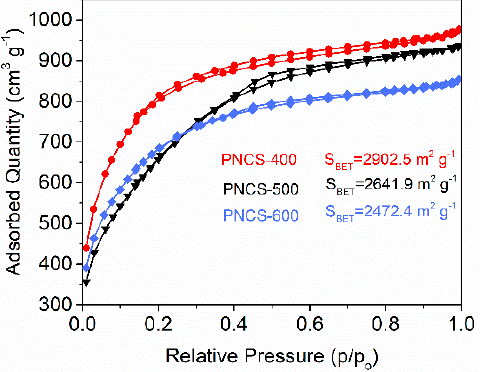
Table 1. Pore parameters of PCNS treated at different calcination temperature and XPS result of O1s for 0.05MnC − 30 − 500 and 0.05MnC − 30.